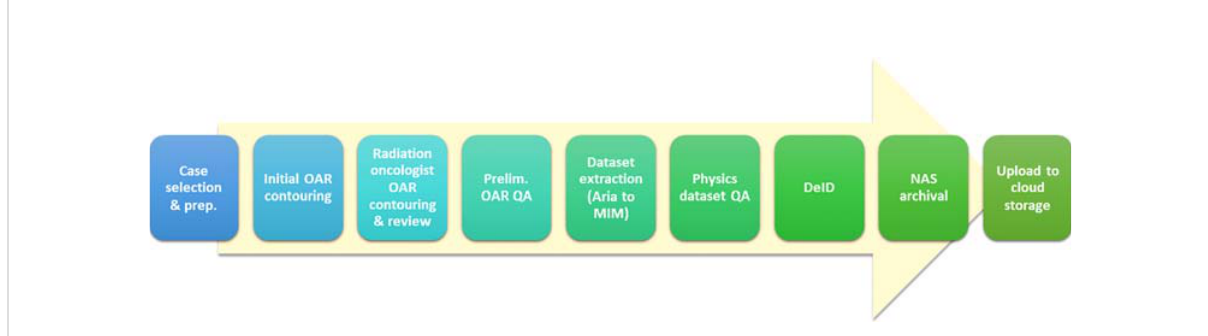
FIGURE 2 Schematic of dataset curation work fl